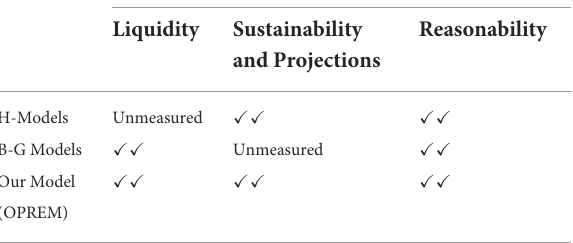
TABLE 1A Models for optimal reserves and their